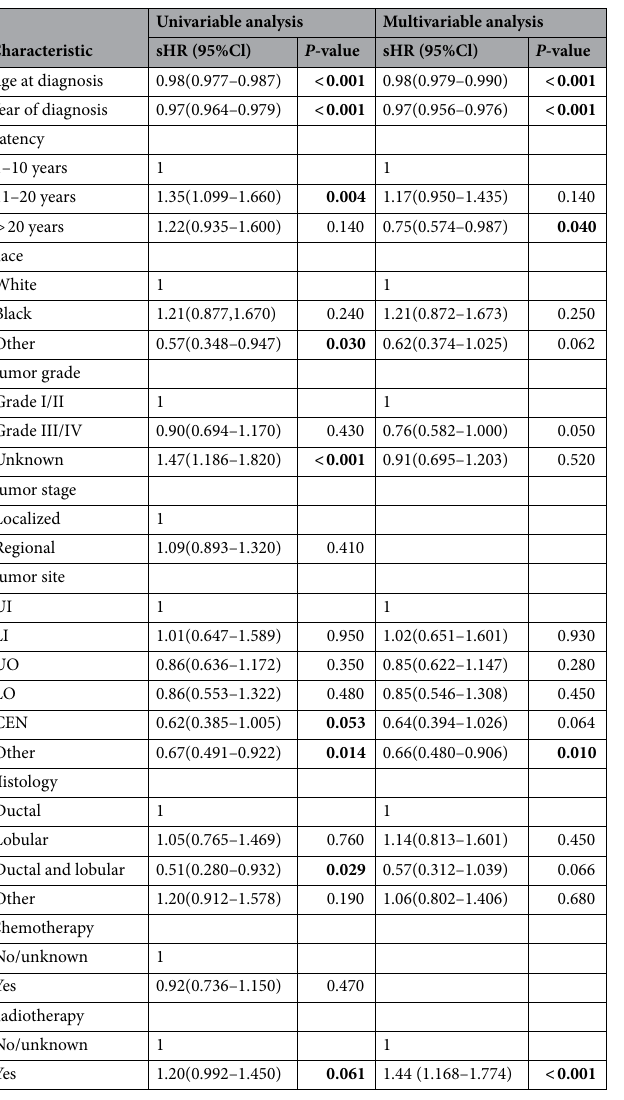
Table 3. Univariable and multivariable competing risk regression analysis of risk of developing SEC in BC patients. sHR hazard ratio; CI confidence interval; BC breast cancer; SEC secondary esophageal cancer; UO upper outer quadrant of breast; UI upper inner quadrant of breast; LI , lower inner quadrant of breast; LO lower outer quadrant of breast; CEN central portion quadrant of breast. The other sites of BC include axillary tail of breast, overlapping lesion of breast. Significant values are in